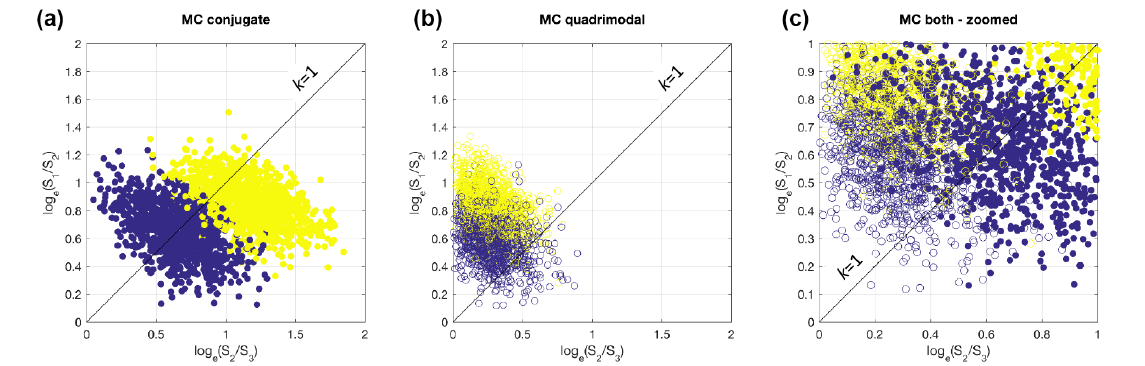
Figure 8. Eigenvalue ratio plots of synthetic data to illustrate the impact of dispersion on the ability of this plot to discriminate between conjugate (bimodal) and quadrimodal fault data. (a) Monte Carlo ensemble of 2000 conjugate fault populations (mixtures of two equal Watson distributions), with κ varying from 5 (dark blue) to 10 (yellow). (b) Monte Carlo ensemble of 2000 quadrimodal fault populations (mixtures of four equal Watson distributions), with κ varying from 5 (dark blue) to 10 (yellow). (c) Data from (a) and (b) merged onto the same plot and enlarged to show the region close to the origin. Note the considerable overlap between the conjugate (bimodal) data with the quadrimodal data, especially for κ = 5 (dark blue).